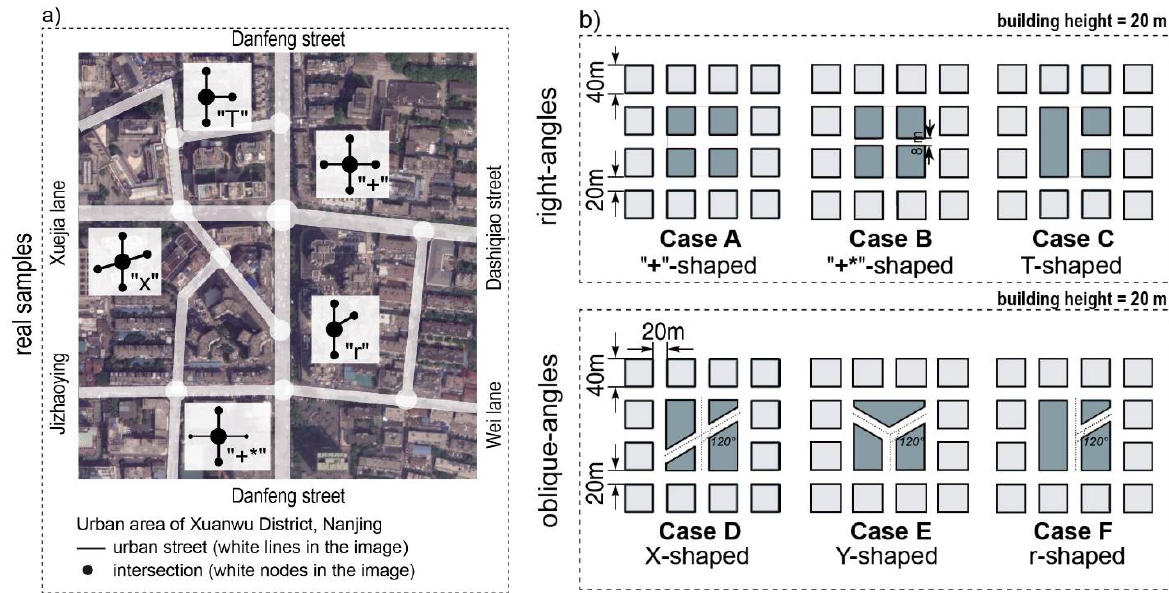
Figure 2. ( a ) Diagram showing several typical intersections in Nanjing, China (base image source: Google Earth): “+”-shaped, “+*”-shaped, X-shaped, T-shaped, and r-shaped; ( b ) six cases of street intersections with a uniform context investigated in this study.